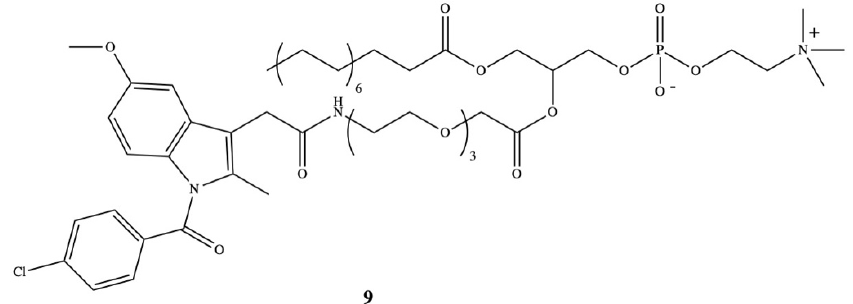
Figure 7. Chemical structure of 1-palmitoyl-2-(11 ′ -N-indomethacincarboxylamino-3,6,9-trioxaun- decanoyl)- sn -glycerophosphocholine (9) .